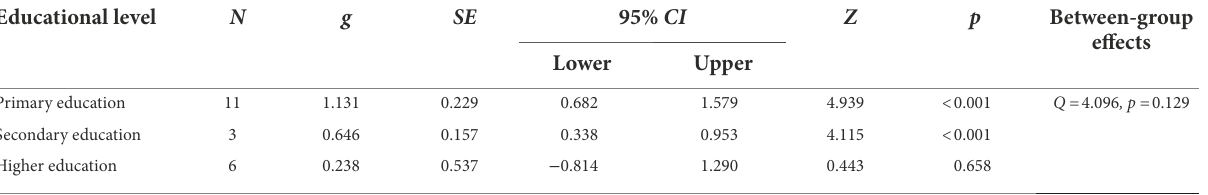
TABLE 2 Impacts of XR on the learning effects, by education